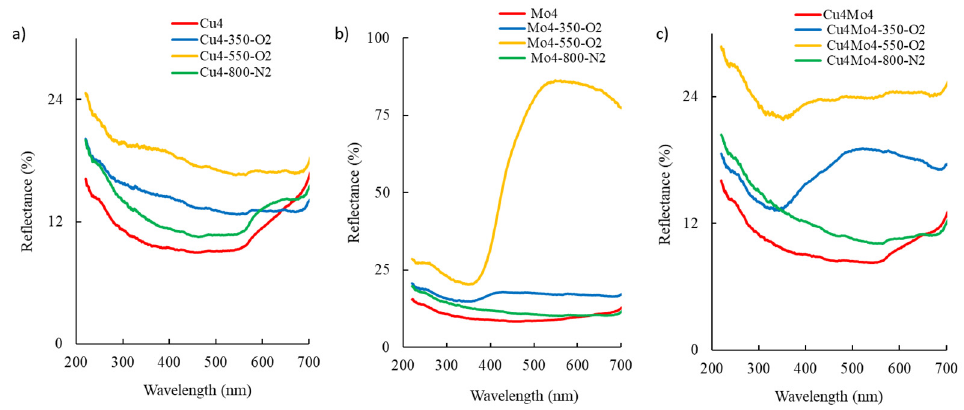
Figure 5. UV–visible diffuse reflectance spectra of the catalysts of the ( a ) Cu series, ( b ) Mo series, and ( c ) CuMo-series.